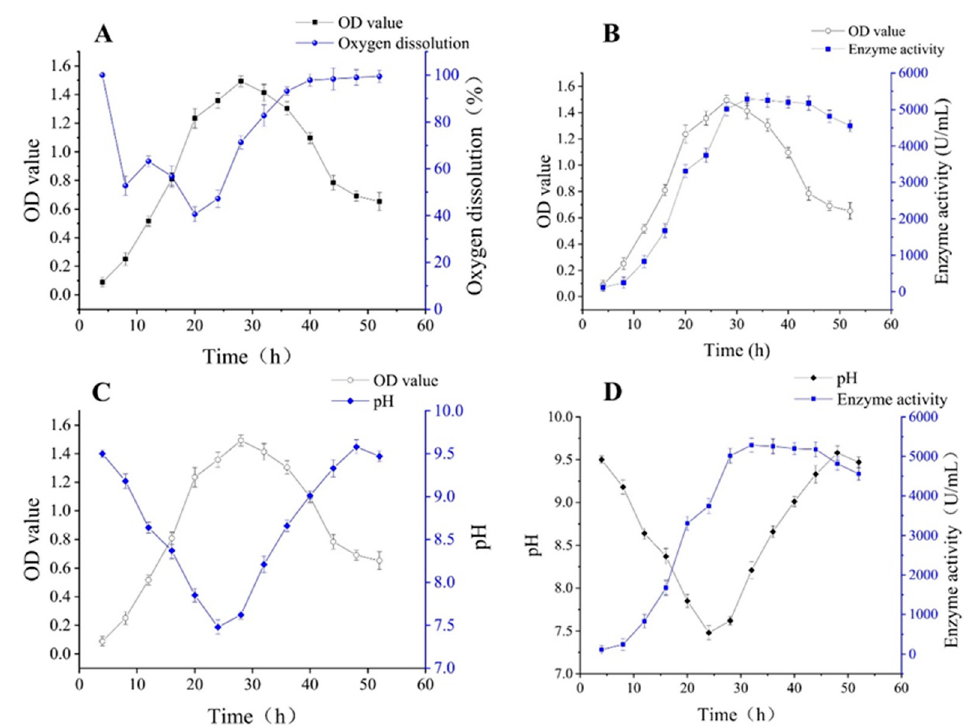
Figure 6. Biomass, oxygen dissolution, enzyme activity and pH variation of palm curtain immobilized Bacillus circulans ATCC 21783 by increasing the rotation speed ( A ) relation of biomass and oxygen dissolution; ( B ) relation of biomass and enzyme activity; ( C ) relation of biomass and pH; ( D ) relation of pH and enzyme activity.